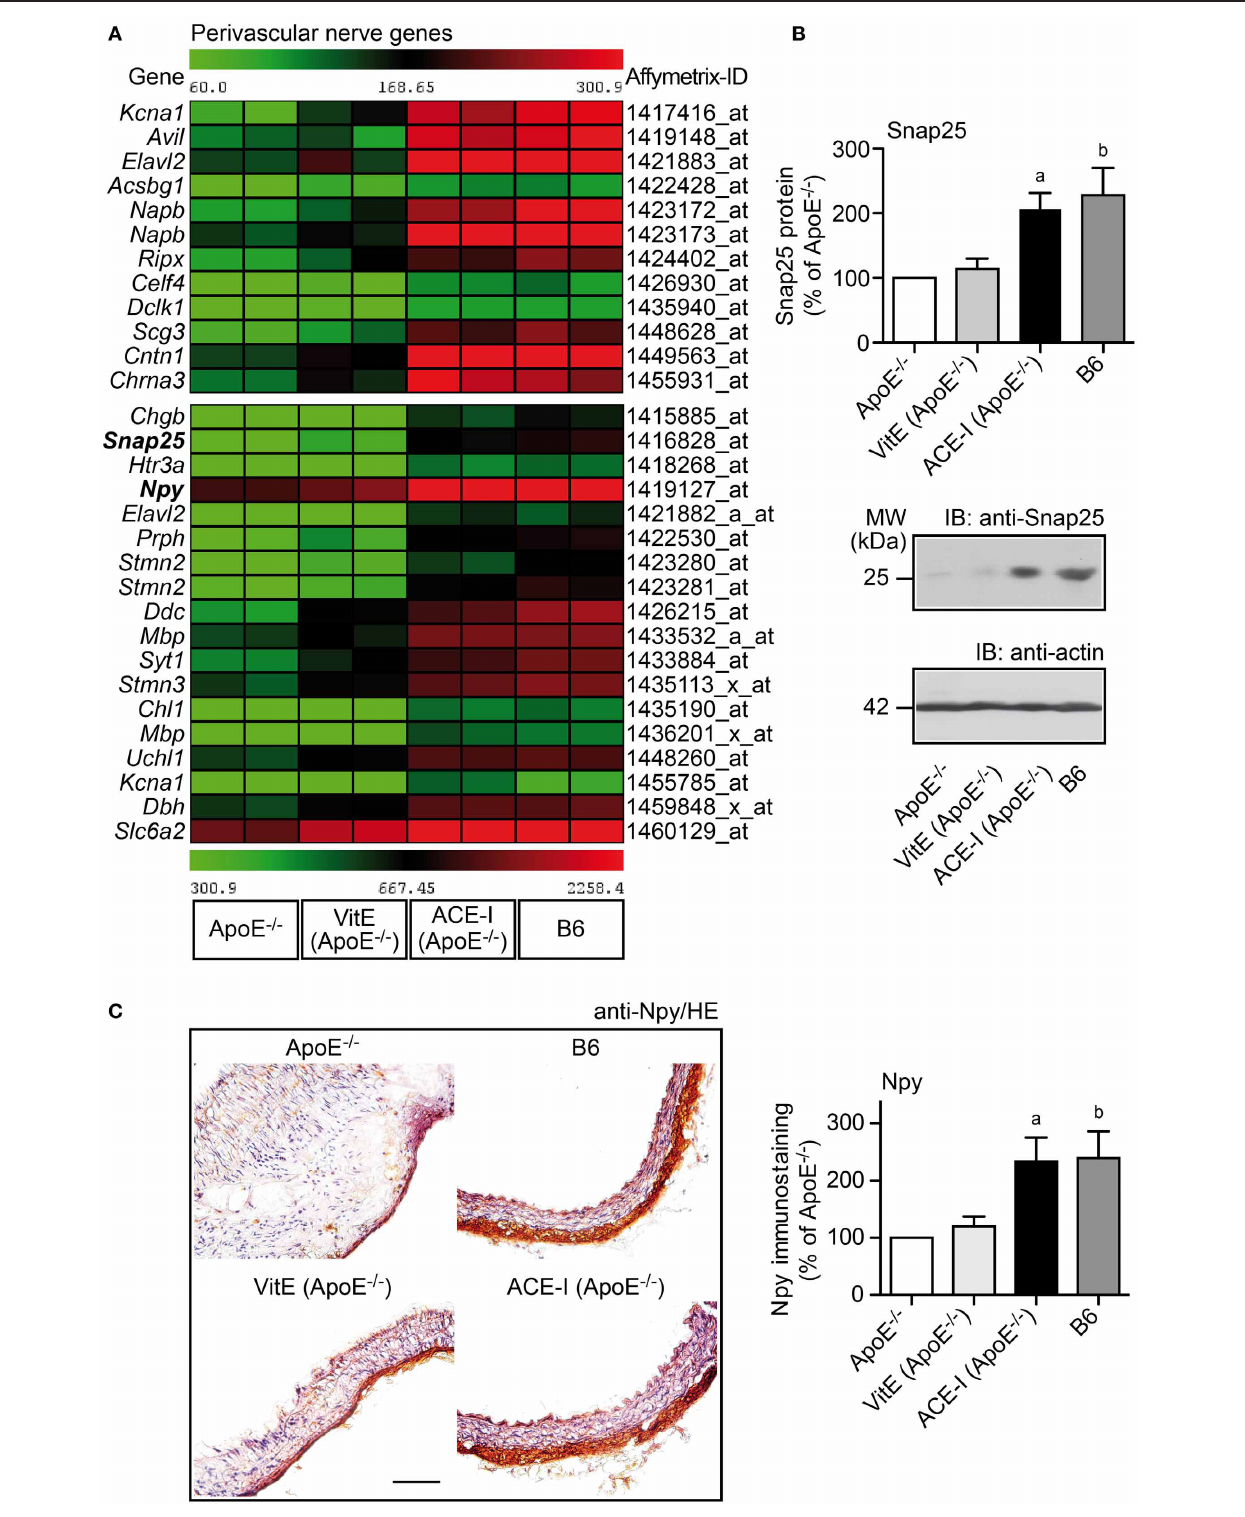
nerve-specific genes, which were significantly down-regulated in ApoE − / − aortas relative B6 controls, are presented as heat map centered to